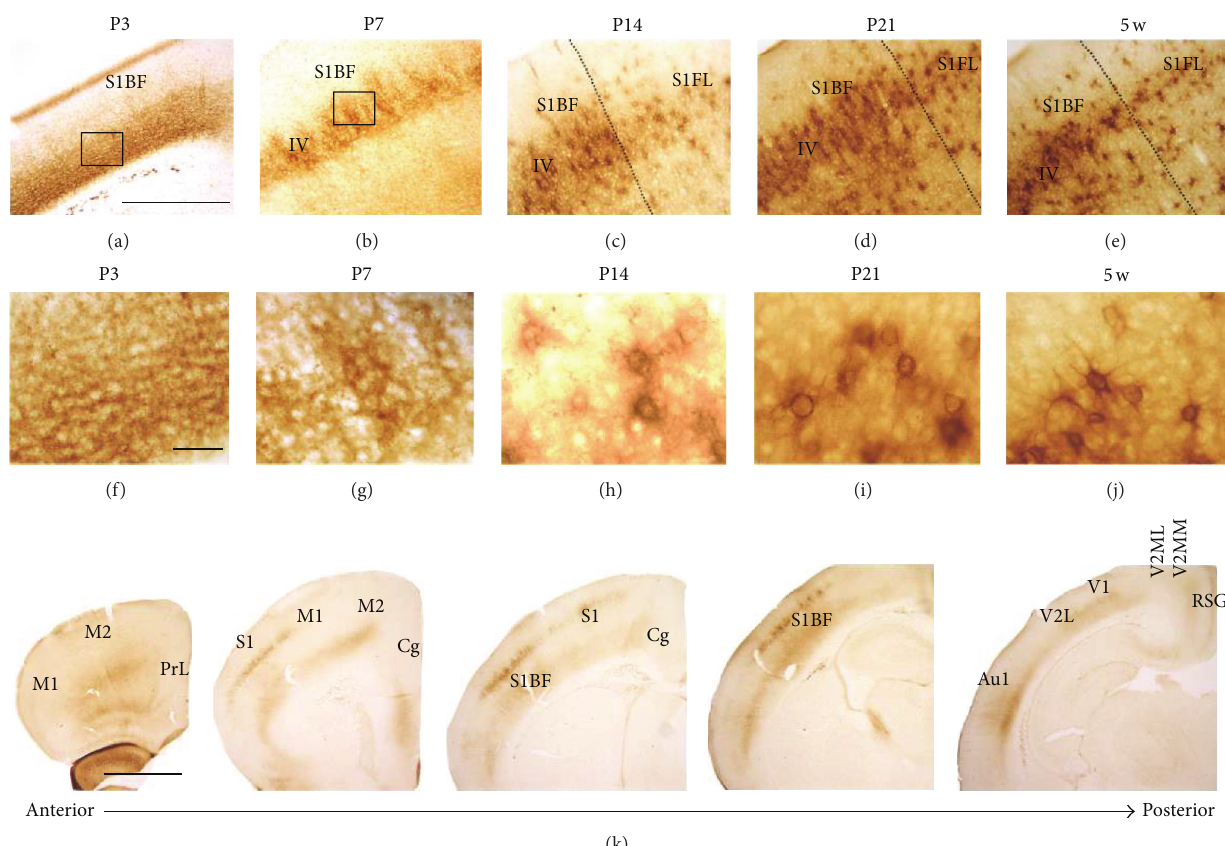
Figure 1: WFA-stained ECM in the developing cortex. (a–j) Low- (a–e) and high- (f–j) power images of WFA staining at P3 (a, f), P7 (b, g), P14 (c, h), P21 (d, i), and 5 w (e, j). Rectangular areas in (a) and (b) indicate the magnified areas shown in (f) and (g), respectively. High-power images (g–j) obtained from cortical IV layer of the S1BF. Dotted lines indicate the border between the S1BF and the S1FL. Accumulation of WFAreactivityaroundparticularcellbodieswasobservedfromP7onward.WFAreactivityclearlysurroundingbothcellbodiesanddendrites was observed from 5 w onward. (k) WFA-labeled serial coronal sections at P7, indicating that PNN-like WFA reactivity was observed in the S1BF, whereas any other regions indicated did not show PNN-like staining. Au1: primary auditory cortex; Cg: cingulate cortex; M1: primary motor cortex; M2: secondary motor cortex; PrL: prelimbic cortex; RSG: retrosplenial granular cortex; S1: primary sensory cortex; S1BF: barrel field of the primary somatosensory cortex; S1FL: forelimb primary somatosensory cortex; V1: primary visual cortex; V2L: lateral area of the secondary visual cortex; V2ML: mediolateral area of the secondary visual cortex; V2MM: mediomedial area of the secondary visual cortex. Scale bars = 500 (a–e), 50 (f–j), and 1000 (k) 𝜇